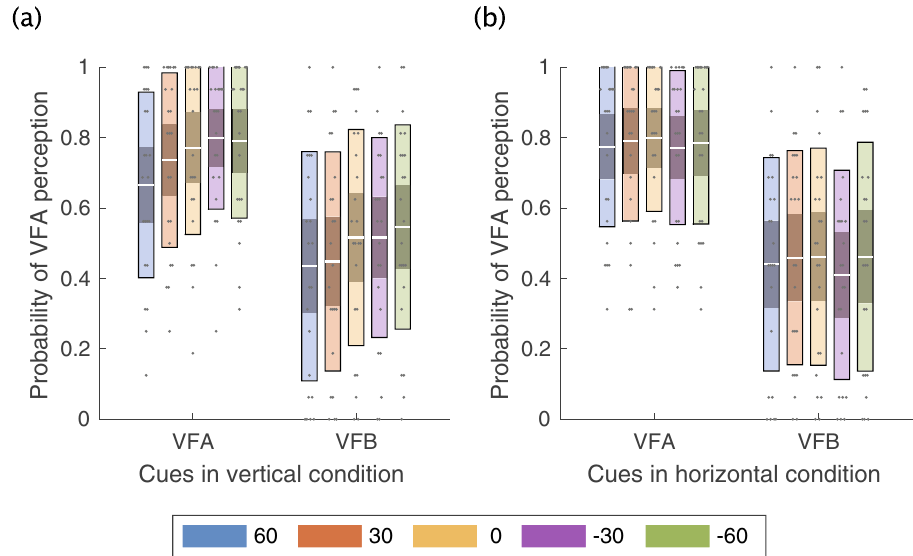
Figure 3. Behavioral results in Experiment 1. (a) The average probability of viewed from above (VFA) perception between cue and angle conditions in the vertical condition across all participants. (b) The average probability of VFA perception between cue and angle conditions in the horizontal condition across all participants. The white line indicates the mean of participants, the light color indicates 1.96 standard error of the mean (95% confidence interval), and the dark color indicates one standard deviation. Each gray dot indicates the mean of each participant. Each color represents the angle at which the stimulus was